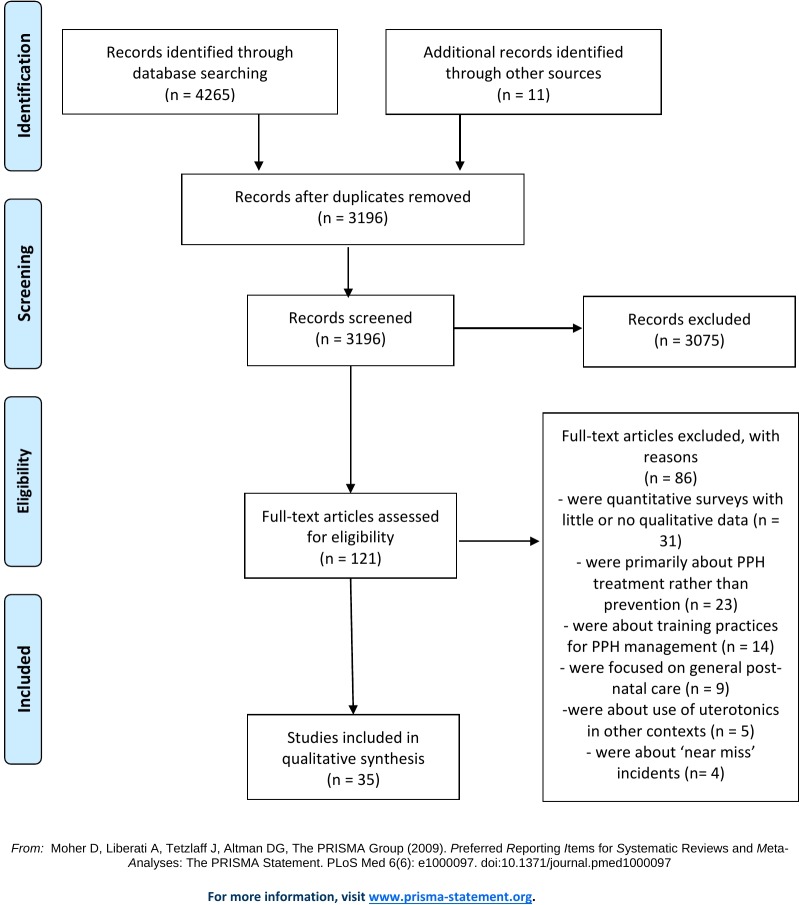
PRISMA flowchart.